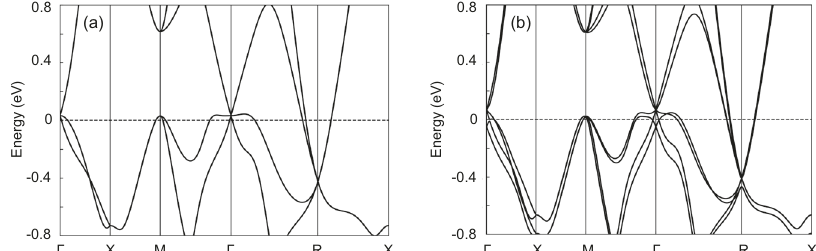
Fig. 3 DFT band structure of RhSi. DFT band structure of RhSi a without spin – orbit coupling and b with spin – orbit coupling. It hosts a threefold fermion at Γ and a fourfold double Weyl fermion at R without spin orbit coupling. They split into a spin-3/2 node and a Weyl node at Γ , and a sixfold double spin-1 node and a twofold Kramers node at R , when spin – orbit coupling is